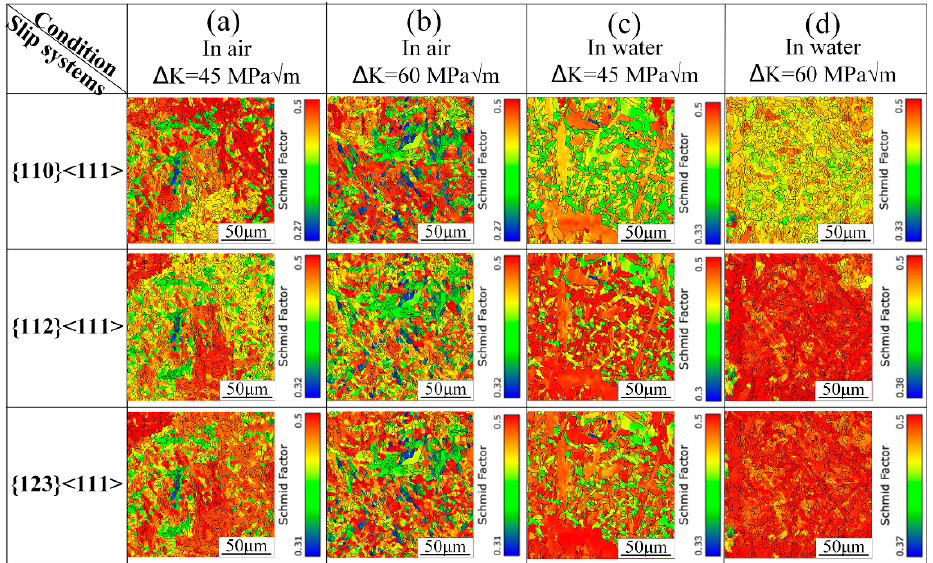
Figure 17. Schmid factors distributions in X80 steel welded joints. ( a ) In air and ∆ K , is 45 MPa·m 1/2 ; ( b ) in air and ∆ K , is 60 MPa·m 1/2 ; ( c ) in water and ∆ K , is 45 MPa·m 1/2 ; ( d ) in water and ∆ K , is 60 MPa·m 1/2 .